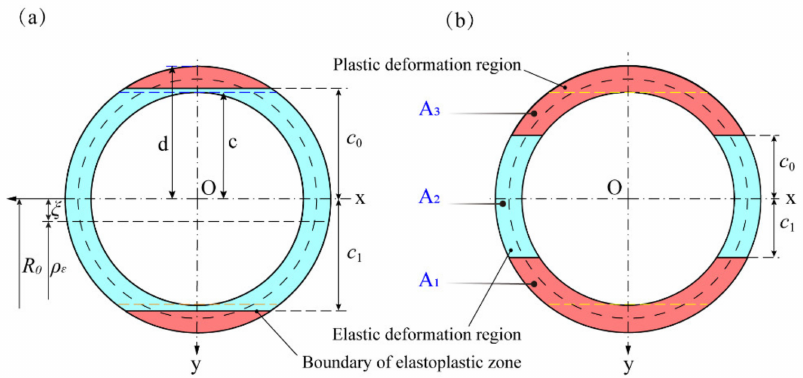
Figure 5. Evolution of the elastic-plastic deformation region of the cross-section. ( a ) The elastoplastic boundary lies between inner radius c and outer radius d along the y-direction; ( b ) The elastoplastic boundary lies between geometric center layer and inner radius c along the